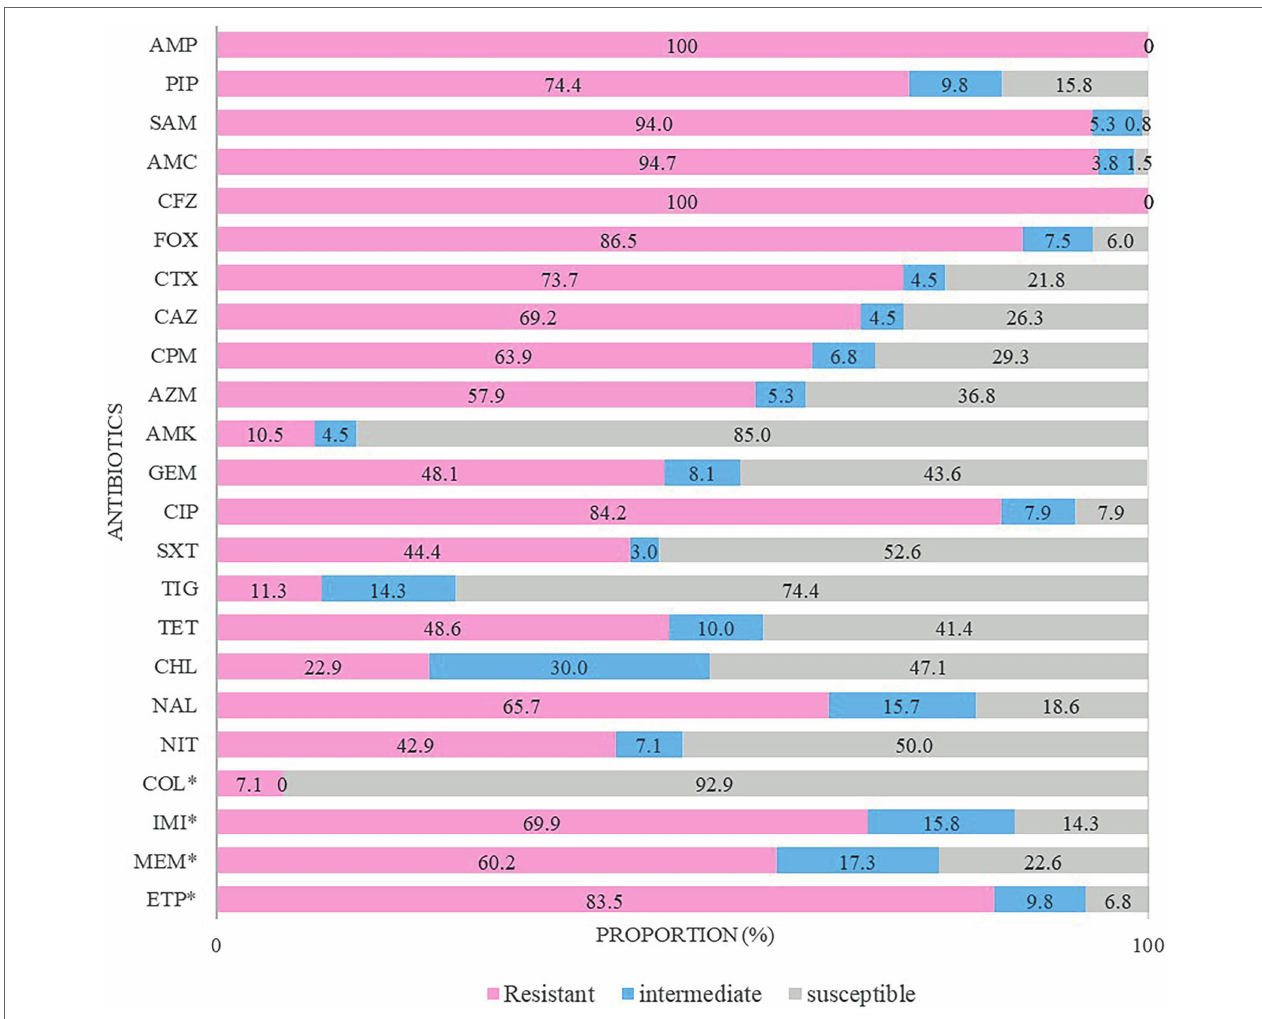
FIGURE 2 | Antimicrobial resistance patterns of carbapenem-resistant Enterobacterales isolates. The antibiotics tested in this study were ampicillin (AMP), piperacillin (PIP), ampicillin/sulbactam (SAM), amoxicillin/clavulanic acid (AMC), cefazolin (CFZ), cefoxitin (FOX), cefotaxime (CTX), ceftazidime (CAZ), cefepime (CPM), aztreonam (AZM), amikacin (AMK), gentamicin (GEM), ciprofloxacin (CIP), trimethoprim/sulfamethoxazole (SXT), tigecycline (TIG), tetracycline (TET), chloramphenicol (CHL), nalidixic acid (NAL), nitrofurantoin (NIT), colistin (COL), imipenem (IMI), meropenem (MEM), and ertapenem (ETP). * They were determined by minimum inhibitory concentration